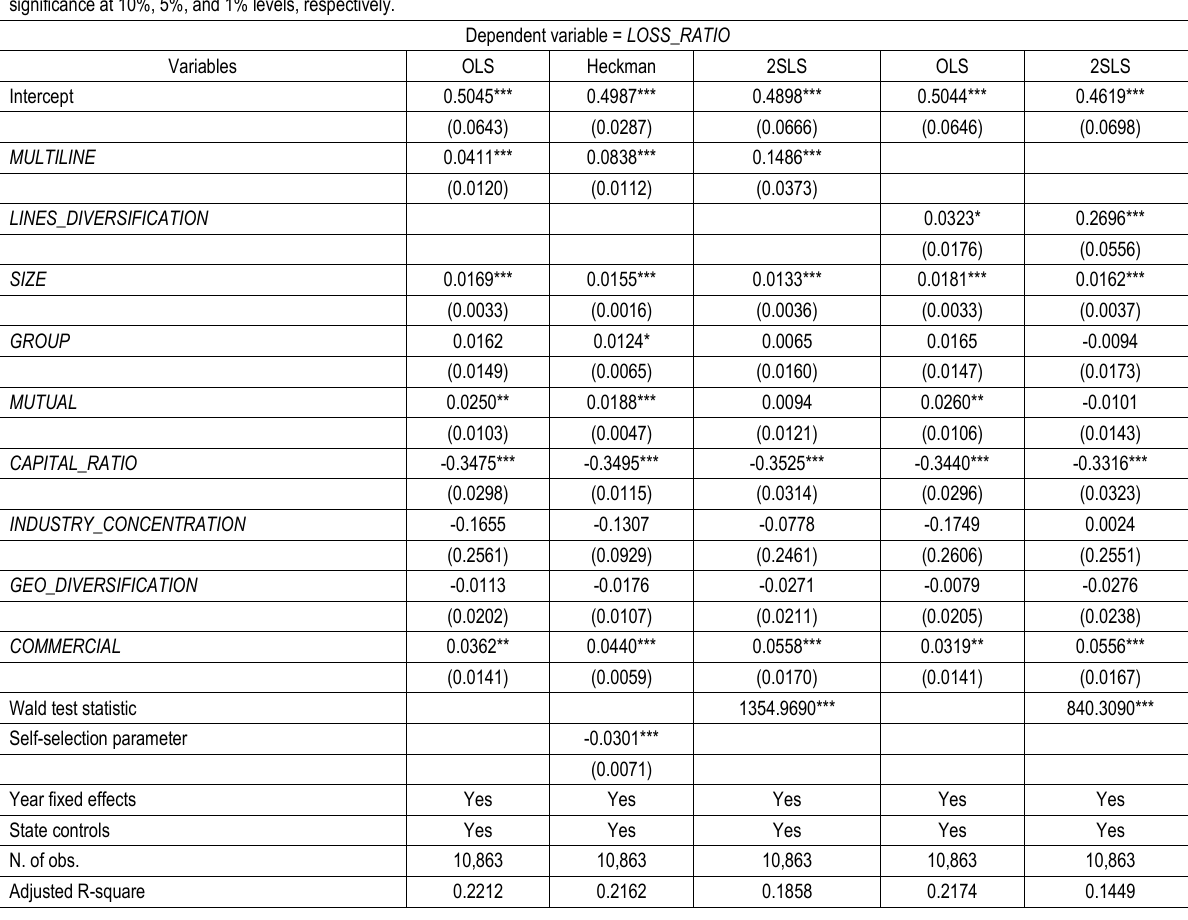
Table 2. Diversification effect on underwriting performance